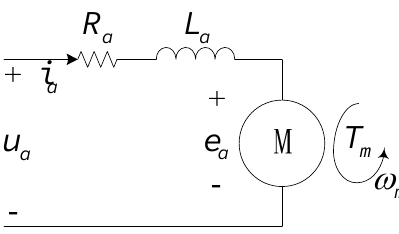
Figure 2. The motor schematic diagram.